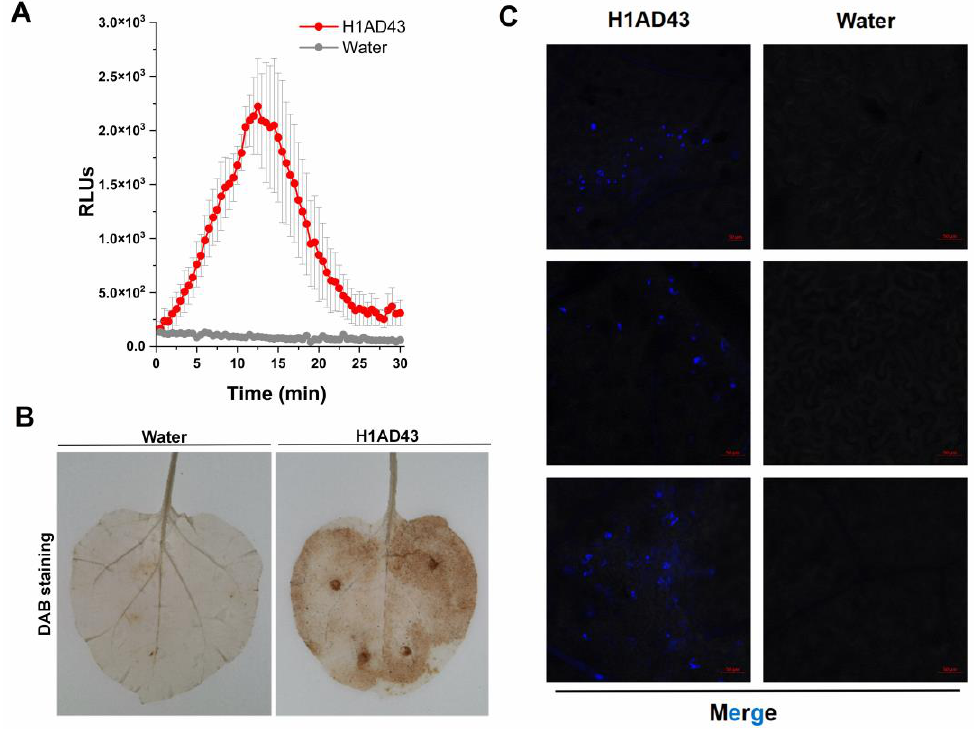
Figure 5. Reactive oxygen species burst and callose deposition. ( A ) H1AD43 triggered an ROS burst in N. benthamiana leaves. ( B ) H1AD43 induced the accumulation of ROS in N. benthamiana